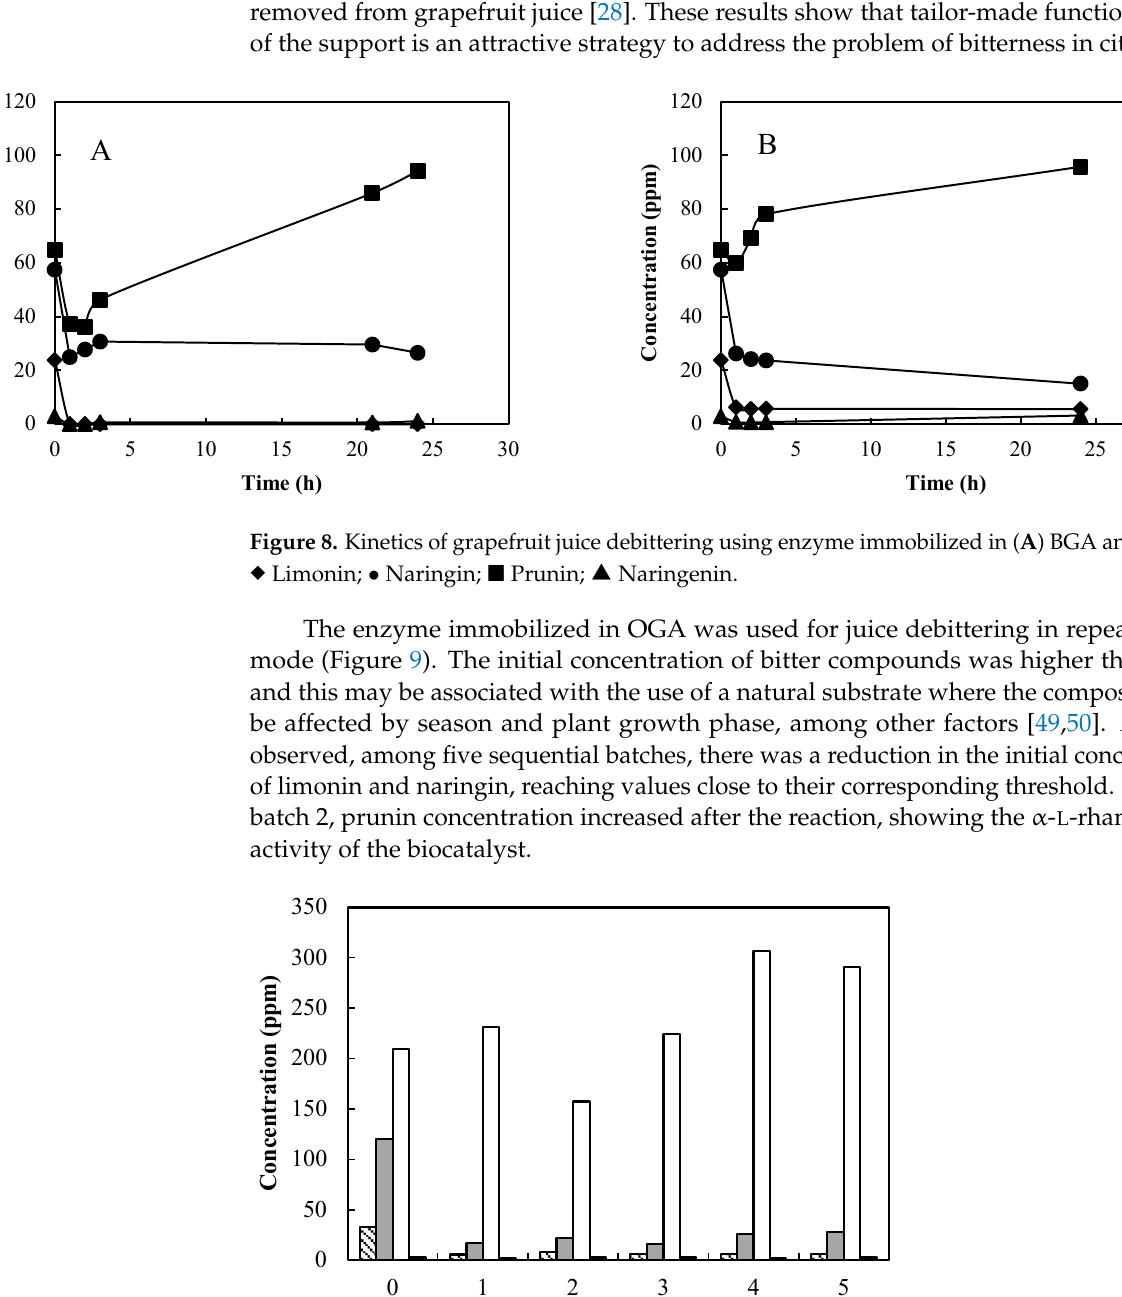
8 of 13 Figure 7. Kinetics of grapefruit juice debittering using enzyme-free supports: ( A ) BGA; ( B ) OGA. ⯁ Limonin; ● Naringin; ∎ Prunin; ⯅ Naringenin. Finally, immobilized biocatalysts were used for grapefruit juice debittering. Figure 8 shows the kinetics of the reactions using enzyme immobilized in BGA and OGA. In both cases, in the first hours of reaction, there was a significant decrease in the concentration of all molecules, as was observed when enzyme-free supports were utilized. However, after this period, the concentration of prunin increased, reflecting the action of the enzyme, specifically α- L -rhamnosidase. Naringenin concentration also increased after 24 h of reac- tion, but at a much lower concentration, indicating lower activity of β- D -glucosidase, as was observed previously with the free enzyme. After 24 h of reaction, BGA and OGA catalysts resulted in 100 and 76% removal of limonin, respectively, while for naringin, the initial concentration was reduced by 54 and 75%, respectively. Limonin concentration af- ter the debittering process was below the detecting threshold [6], independent of the sup- port utilized for enzyme immobilization. In the case of naringin, only biocatalyst immo- bilized in OGA allowed for a final concentration below its detection threshold [9]. The use of immobilized catalysts resulted in a hybrid approach for juice debittering, with enzyme immobilized in OGA obtaining better results than soluble enzyme alone or enzyme-free